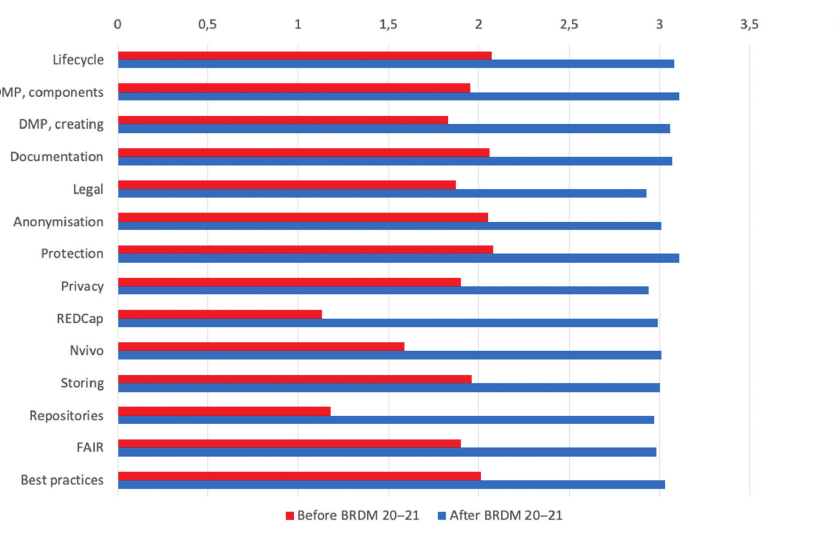
Fig. 7: Based on median self-ratings, respondents’ competencies related to the specified learning objectives before and after the BRDM 2020–2021 courses. Light blue bars represent the competencies before the courses and dark blue bars after the courses. Full descriptions of the learning objectives can be found in the survey form (Appendix